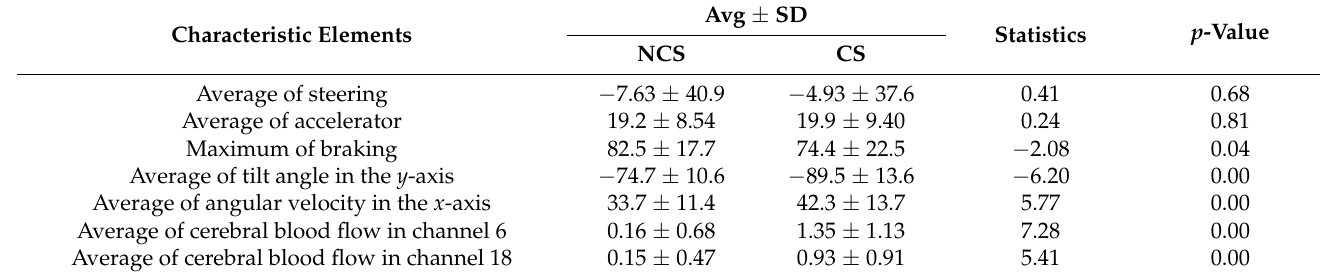
Table 10. Characteristics of behavior and cognition of young drivers when they feel